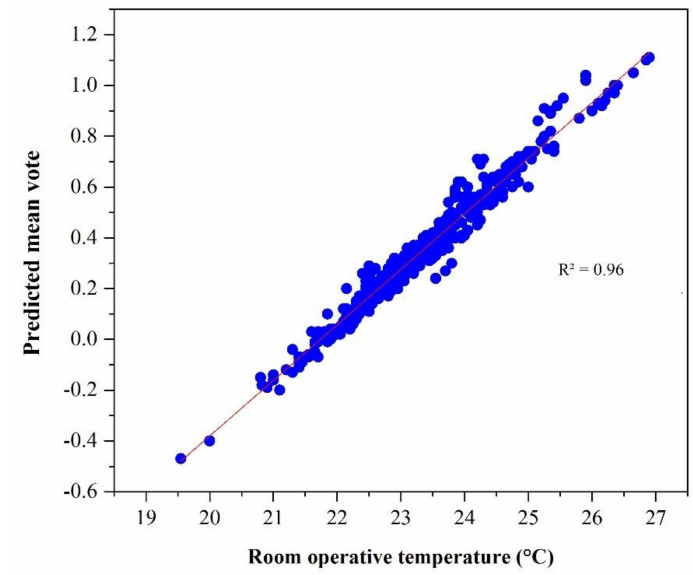
Figure 7. Predicted mean vote versus operative temperature. Based on Equation (5) and as shown in Figure 8, when the indoor operative tempera- ture is higher than 22.7 ◦ C or lower than 20.8 ◦ C, the PPD is outside the neutral thermal comfort zone (PPD < 6%: the range with the smallest percentage of environmental dissatis- faction) recommended for spaces occupied by fragile people with special needs [40]. To ensure a higher thermal comfort level, the optimal temperature is calculated based on the adaptive thermal comfort model.